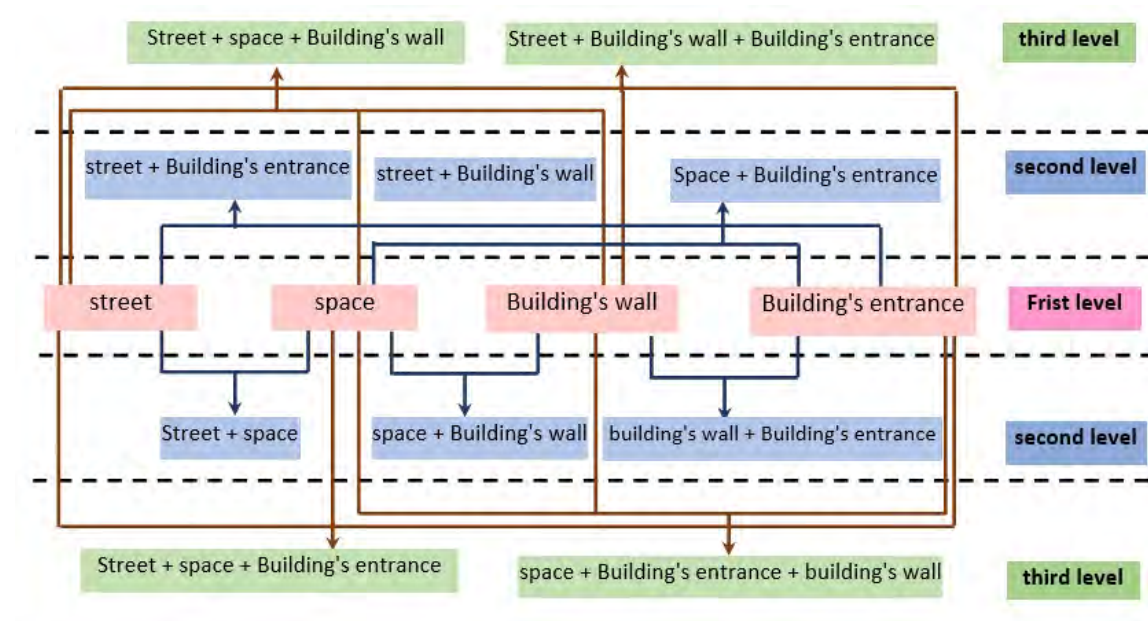
Figure 1. The possibilities of a side limits for space location pattern